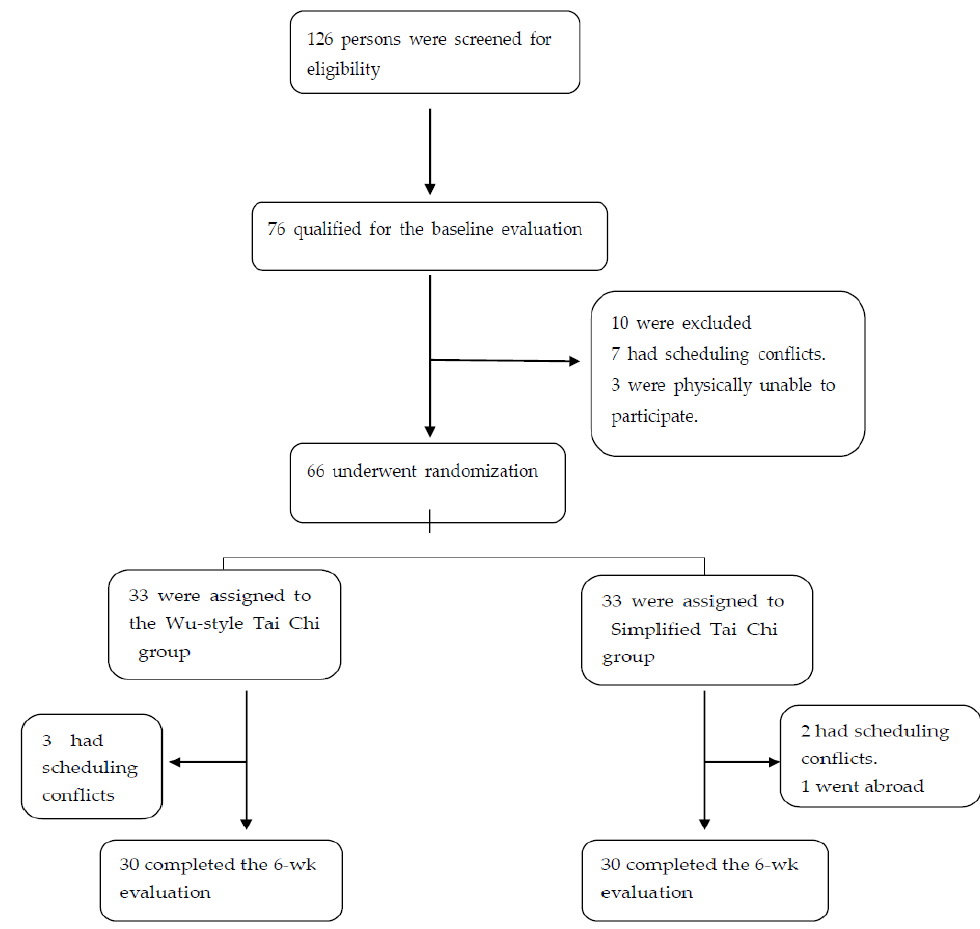
Figure 1. Screening, randomization, and completion of baseline and 6-week evaluations.